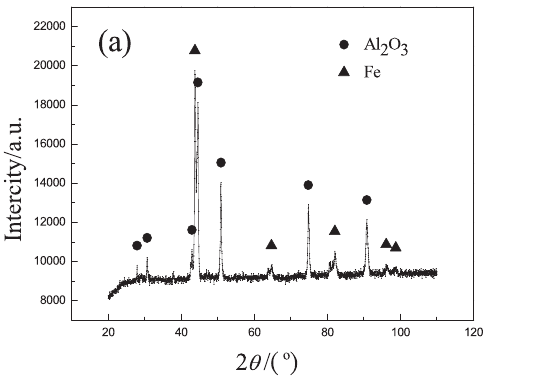
Fig. 2: XRD pattern (a) and cross-sectional morphology (b) of the PO